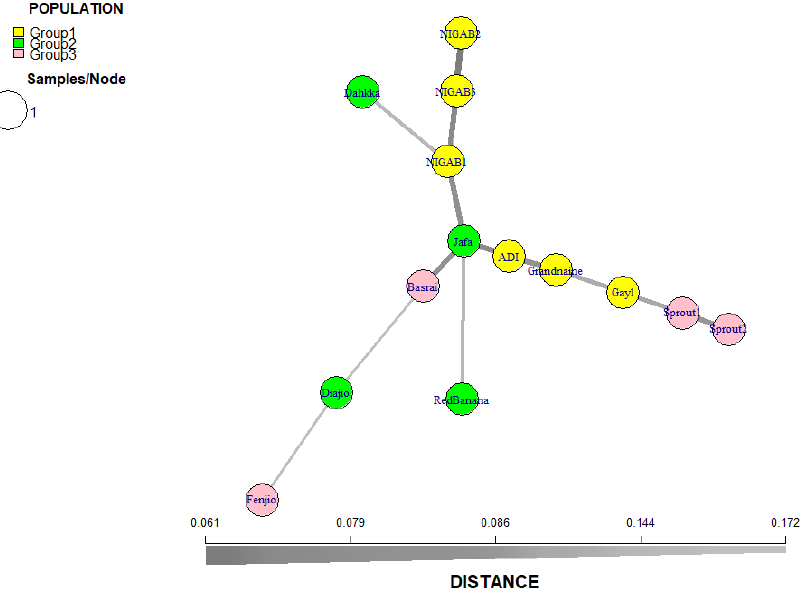
Figure 3. Minimal spanning tree based on Hemming Nei’s genetic distance for three groups of banana varieties.